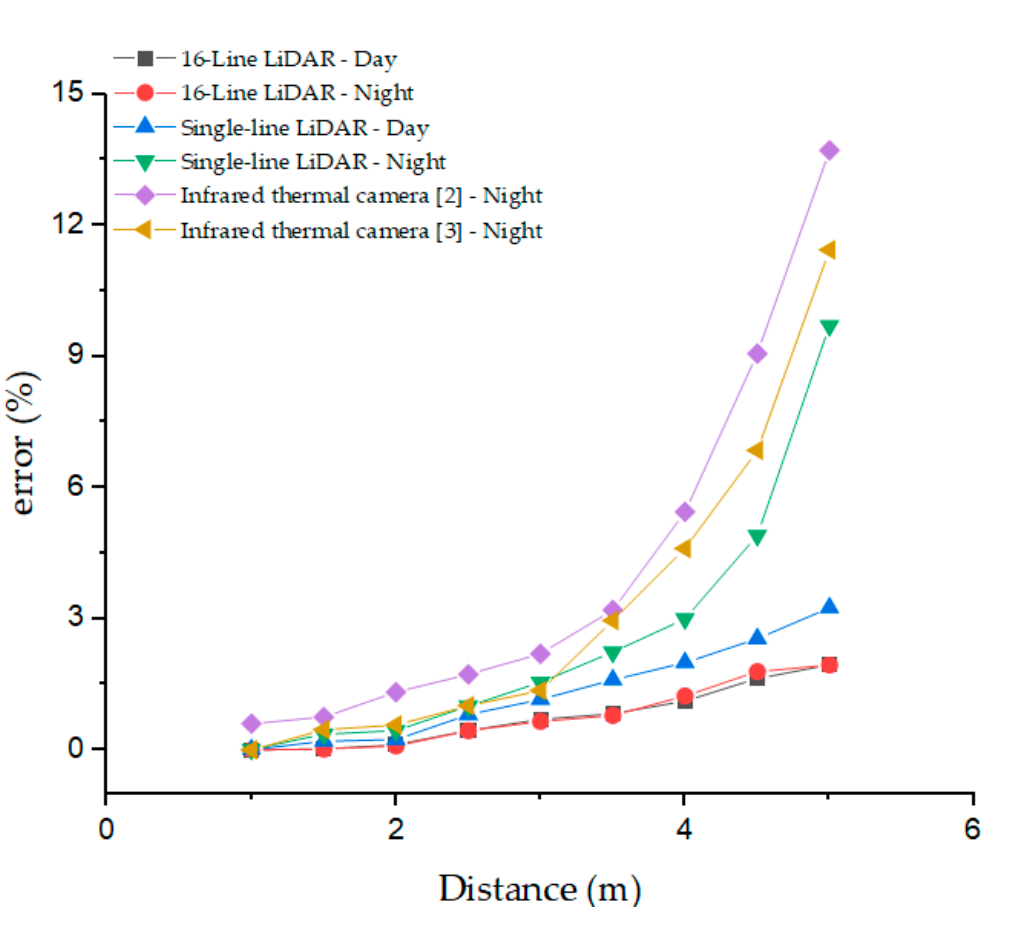
Figure 19. Comparison diagram of negative obstacle detection performance.